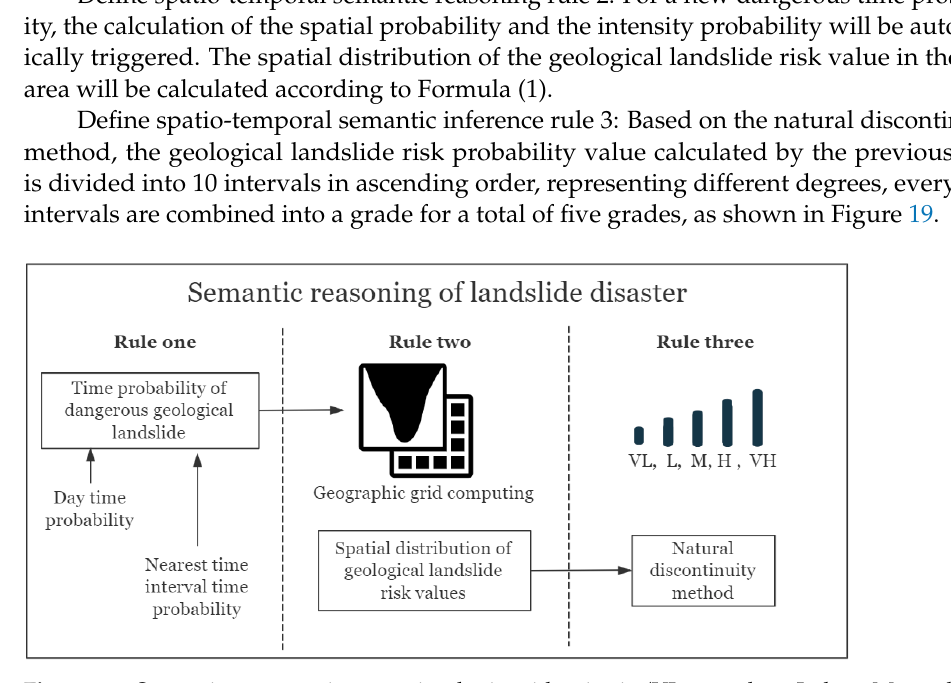
Figure 19. Space-time semantic reasoning logic with criteria (VL: very low, L: low, M: moderate, H: high, VH: very high) .